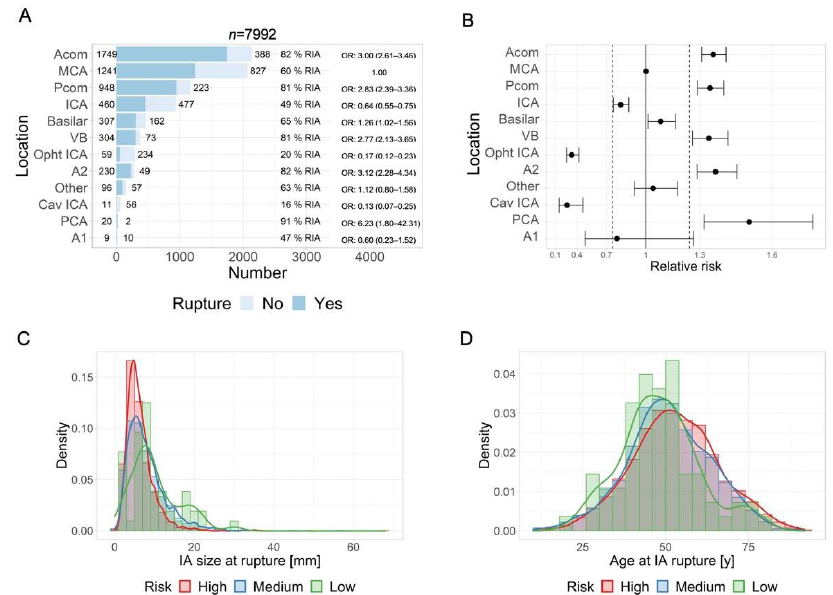
Figure 3. Intracranial aneurysm locations and risk of rupture. ( A ) Number of ruptured (dark blue) and unruptured (light blue) aneurysms for each IA location. ( B ) Relative risk for IA rupture, by IA location. The solid vertical line represents the relative risk for MCA. The dashed lines separate low-risk locations (left side) and high-risk locations (right side) from medium-risk locations (middle). ( C ) Distribution of IA size at rupture in high-risk (Acom, Pcom, VB, A2, and PCA, in red), medium-risk (MCA, ICA, basilar, A1, and other locations, in blue) and low-risk (Opht-ICA and Cav-ICA, in green) locations for rupture. ( D ) Distribution of patient’s age at rupture in high-risk (red), medium-risk (blue), and low-risk (green) IA locations for rupture. Acom: anterior communicating artery; MCA: middle cerebral artery; Pcom: posterior communicating artery; ICA: internal carotid artery; VB: vertebra-basilar artery, ophtl-ICA: ophthalmic segment of ICA, A2: anterior cerebral artery distal to Acom, cav-ICA: carotid-cavernous ICA, PCA: other posterior circulation arteries, A1: A1 anterior segment.